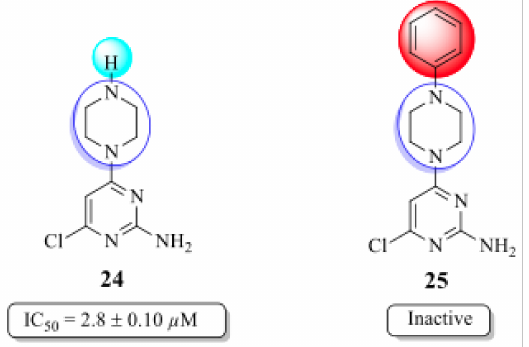
Figure 2. Bar chart diagram for β -glucuronidase Inhibitory activity of compounds 1–27 .